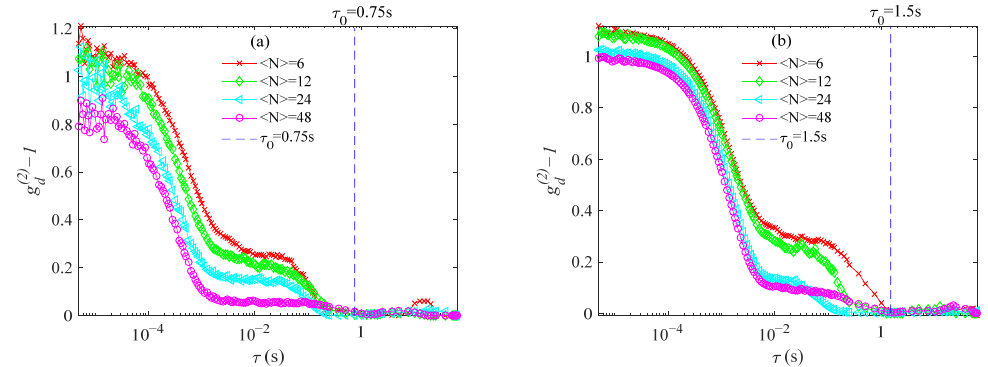
Figure 11. Measured ACFs of standard polystyrene latex particles for concentrations of < N > = 6, 12, 24, and 48: ( a ) 152 nm diameter and ( b ) 693 nm diameter.